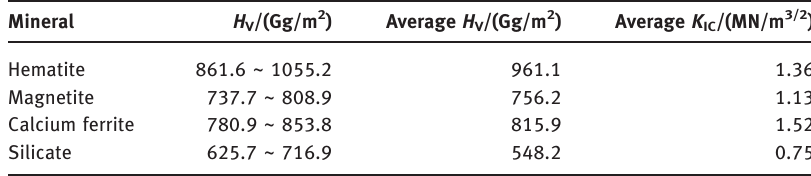
Table 3: Indices of micromechanical properties of vanadium-titanium sinter. Mineral H V /(Gg/m  ) Average H V /(Gg/m  ) Average K IC /(MN/m  /  ) Hematite  .  ~  .   .   .  Magnetite  .  ~  .   .   .  Calcium ferrite  .  ~  .   .   .  Silicate  .  ~  .   .   . 